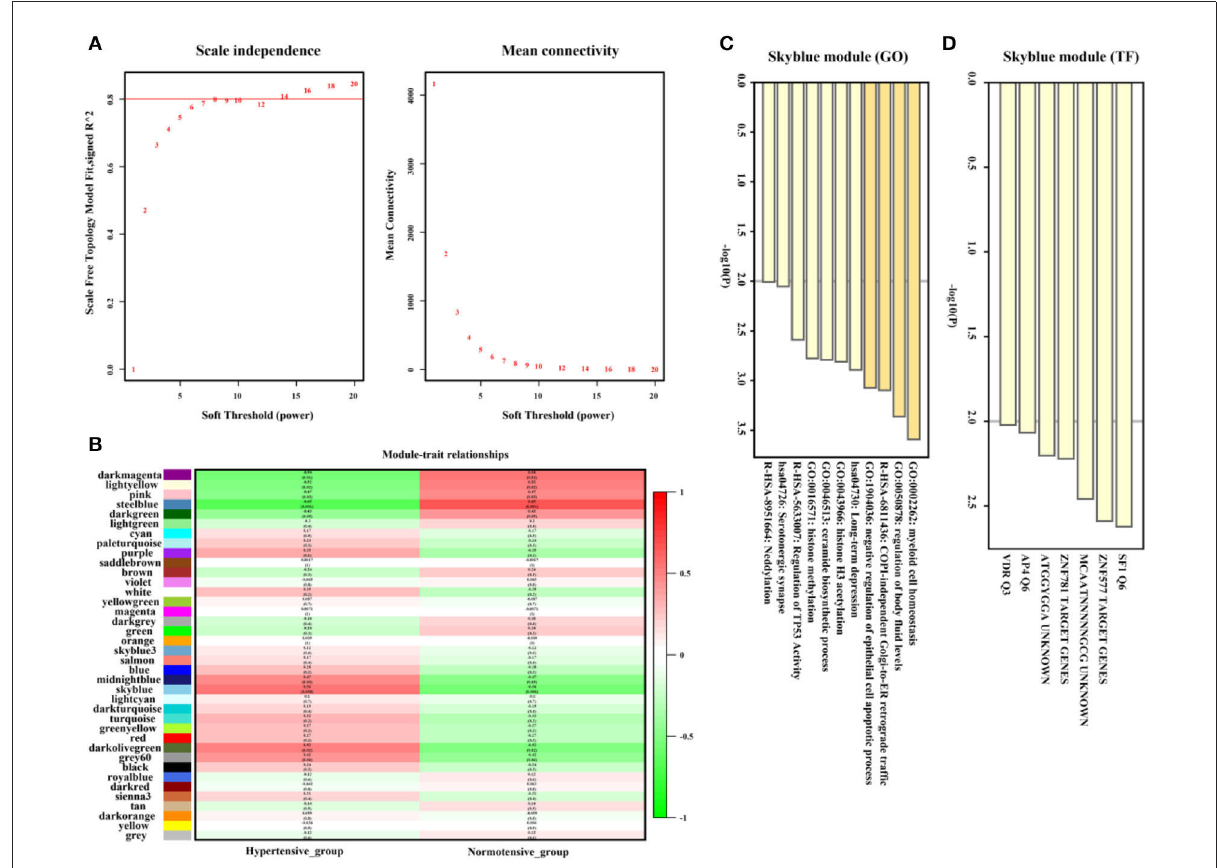
FIGURE5 Hypertension-related gene module selection and functional enrichment analysis (GSE75360). (A) Robust threshold value to the selection. (B) A heatmap displaying the associated with hypertension trait and neighboring genes modules. (C) The Gene Ontology (GO) and Kyoto Encyclopedia of Genes and Genomes (KEGG) enrichment analysis for optimal hypertension-related gene module. (D) Transcript factors enrichment analysis for an optimal hypertension-related gene